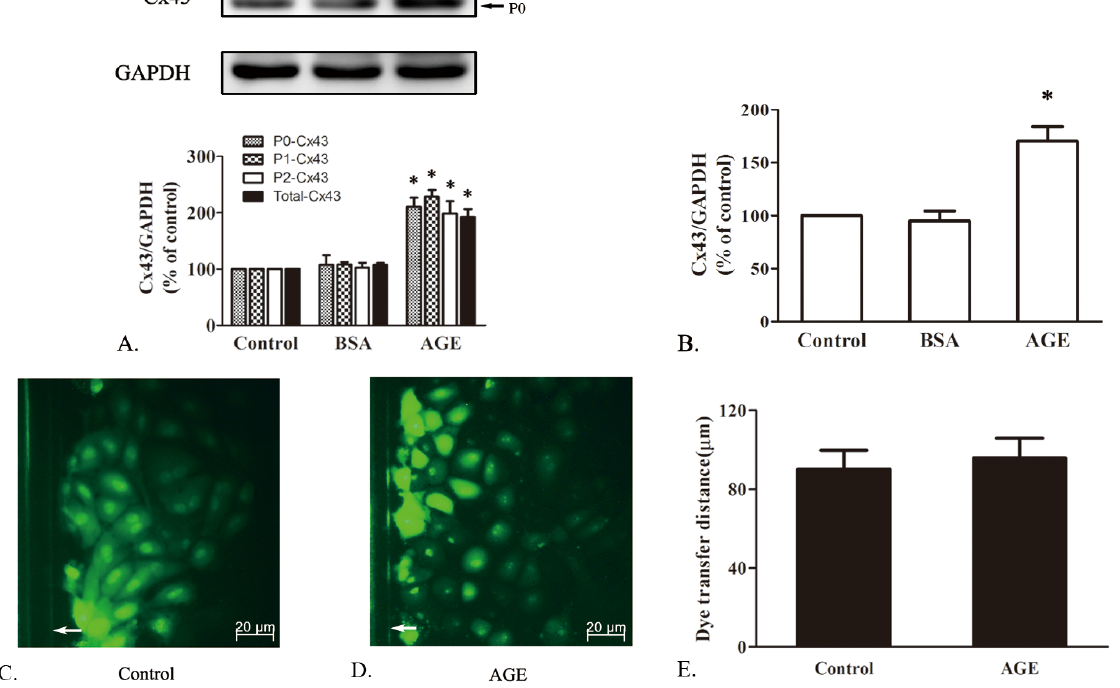
Figure 4. The effect of AGE on Cx43 expression and gap junctional intercellular communication (GJIC) function. ( A ) Cx43 protein (P0, P1, P2) expression was upregulated by AGE (200 mg/L) treatment for 24 h; ( B ) Cx43 mRNA level was upregulated by AGE (200 mg/L) treatment for 24 h. ( C ) and ( D ) showed effect of AGE on the GJIC function assessed by Scrape loading dye transfer assay; ( E ) The quantity analysis of dye transfer distance in each group. * p < 0.05 vs. control, BSA (200 mg/L); White arrow: scrape line; Data are mean ±